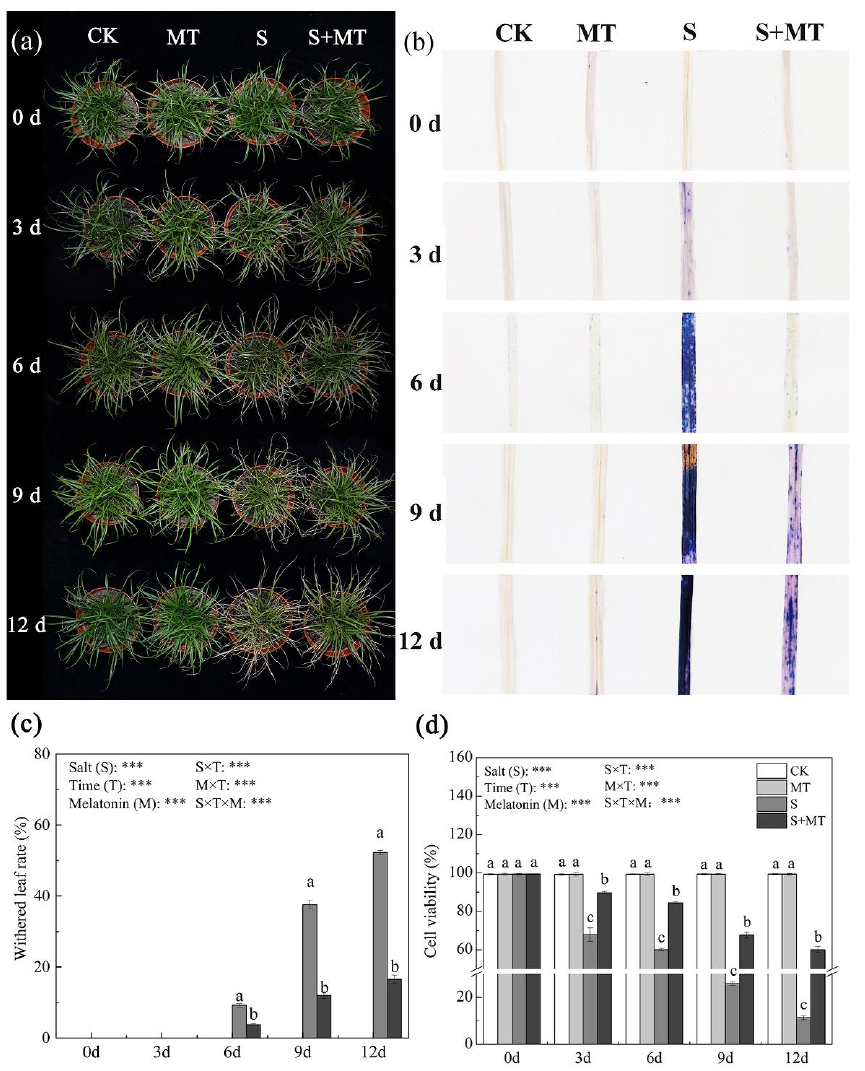
Figure 1. Effects of foliar application of melatonin on the growth phenotype and cell activity of C. leucochlora seedlings under salt stress. ( a ) Images showing the changes in the C. leucochlora seedling growth phenotype (one pot was randomly selected from each treatment ( n = 15) for photography); ( b ) detection of cell activity in C. leucochlora leaves by Evans blue staining (one leaf was randomly selected from each treatment ( n = 15) for photography); ( c , d ) bar charts showing the changes in C. leucochlora cell viability. The error bars represent the standard deviation. Significance levels are presented for each main effect or interaction. *** p < 0.001.